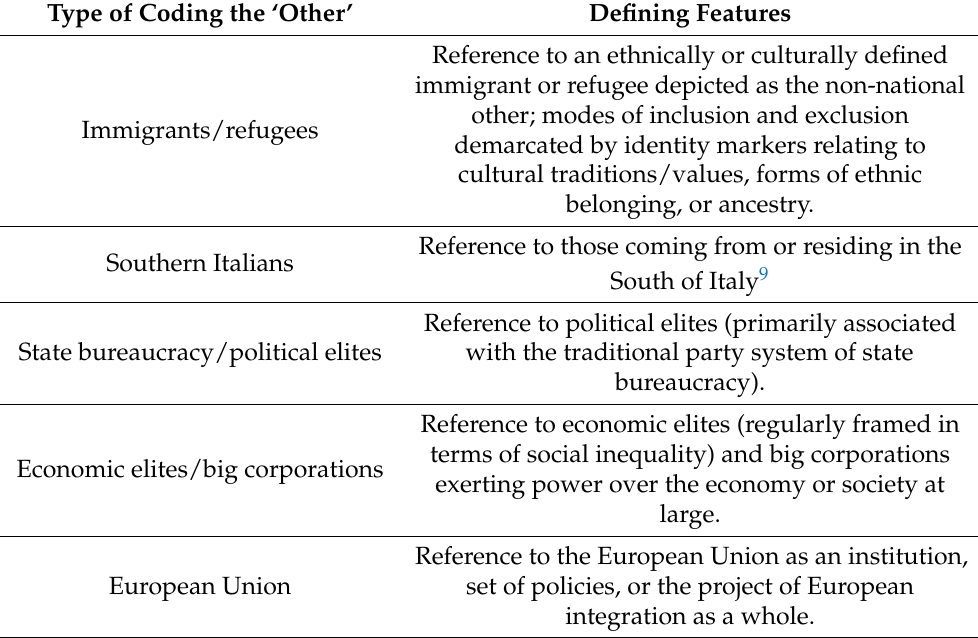
Table 1. Modes of defining the ‘Other’ in Lega’s discourse on the ‘people’. Type of Coding the